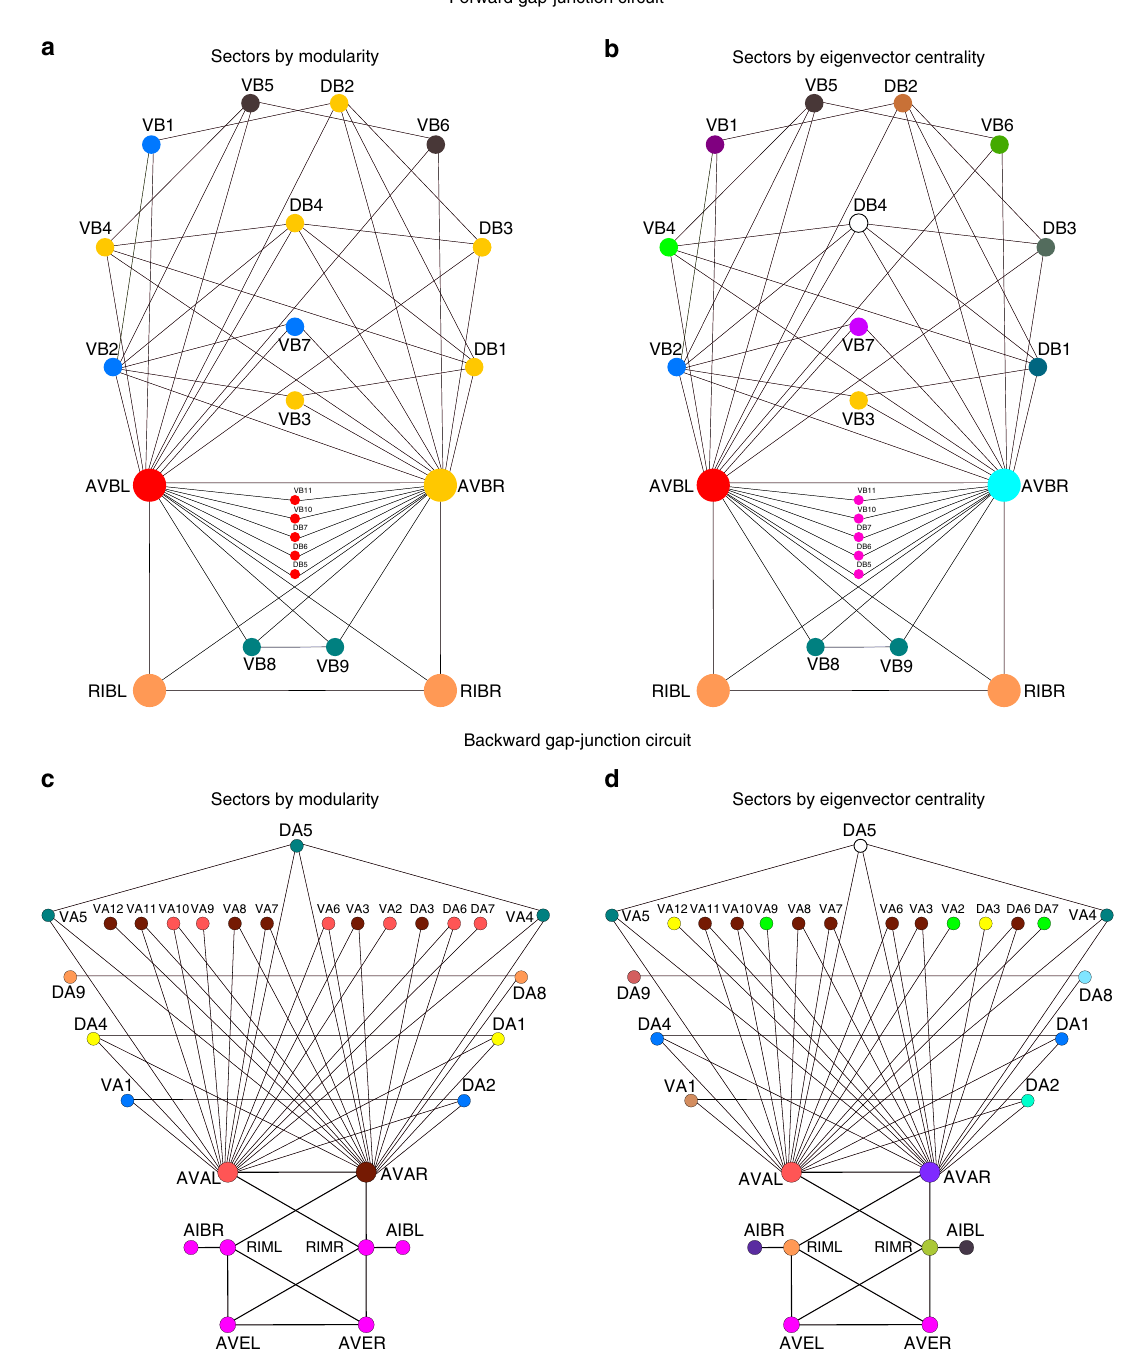
Fig. 5 Symmetry vs. other methods. We compare the functional classes obtained from symmetries with modularity detection algorithms 27,28 and a typical eigenvector centrality measure. a Forward gap-junction circuit classes obtained using modularity or community detection detection algorithm from ref. 28 and ( b ) using eigenvector centrality. c Backward gap-junction circuit modularity and ( d ) eigenvector centrality. Both measures, modular detection and centrality, do not capture the symmetries and functional classi fi cation of this